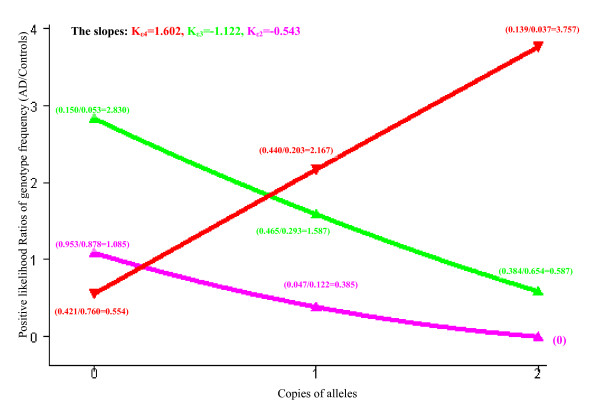
Dose effects of APOE gene alleles. X-axis represents the copies of alleles (ε2 allele, pink line; ε3 allele, green line; ε4 allele, red line); Y-axis represents the positive likelihood ratios of genotype frequency (in AD cases vs. in Controls)